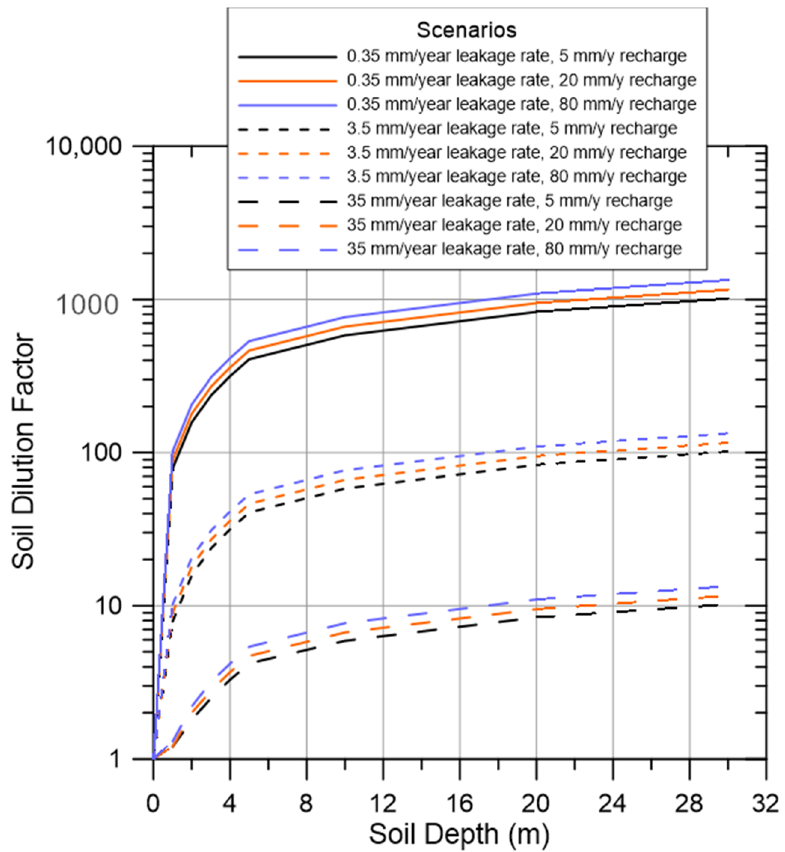
Figure 6. Soil dilution factor ( DF L ) as function of soil depth for loam soil. DF L is calculated at the soil-groundwater interface (three-year leak).